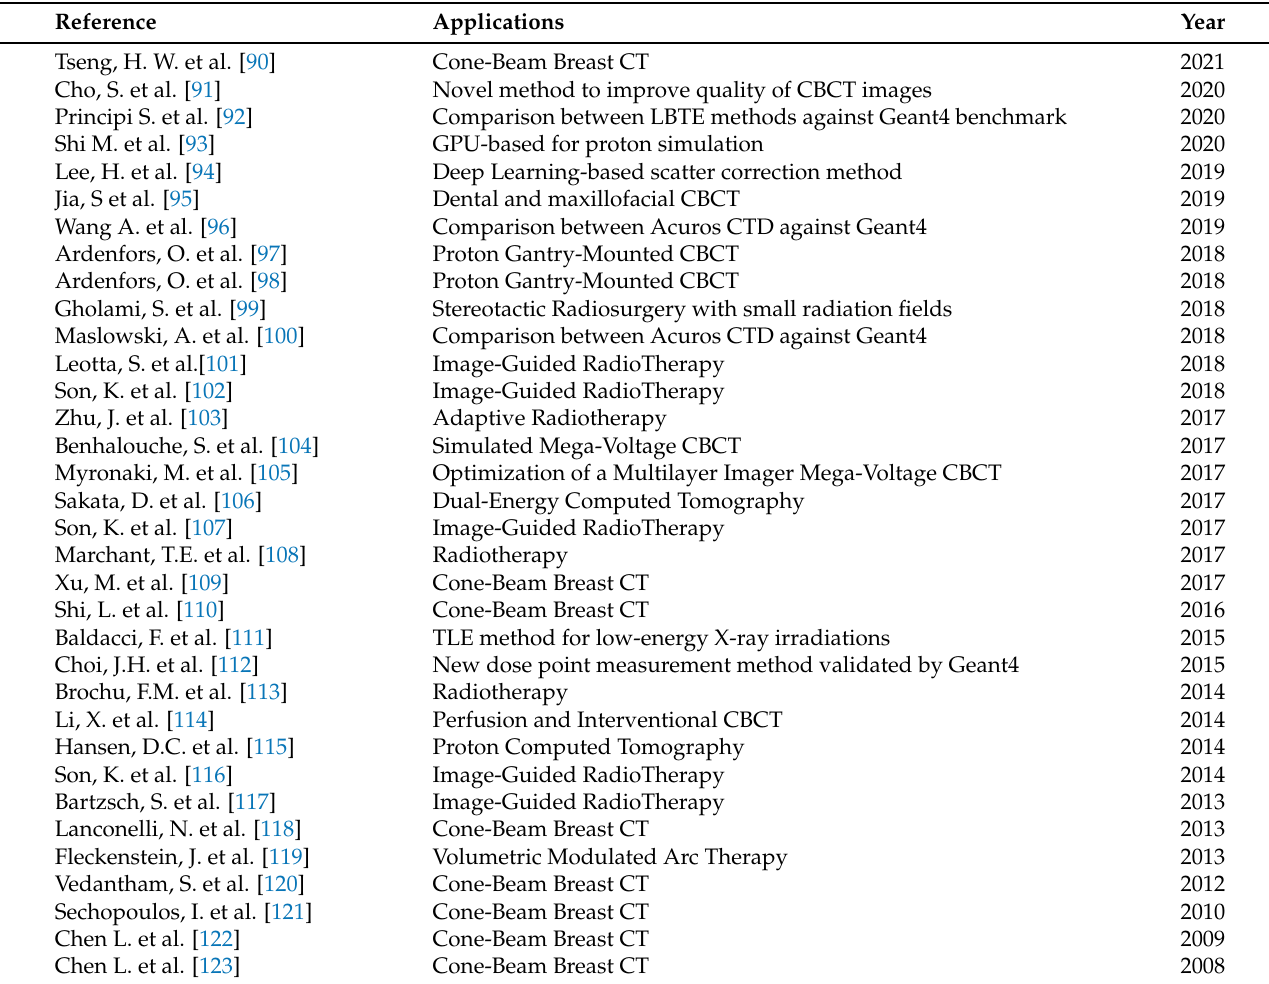
Table 3. Overview of extracted data from papers regarding reference named by first author, applications, and year of